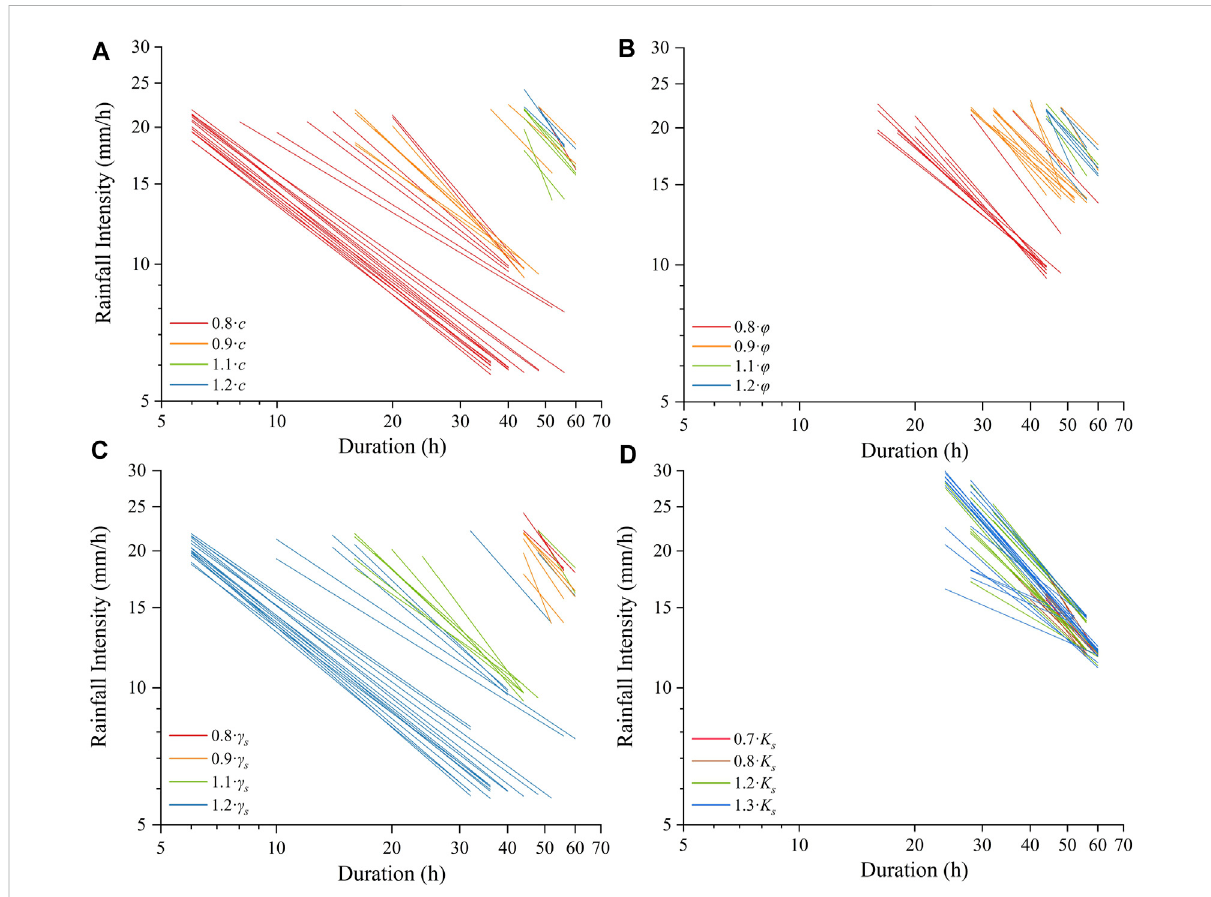
FIGURE 8 I-D thresholds de fi ned at the slope unit scale under given soil mechanical and hydraulic parameters: (A) c , (B) φ , (C) γ